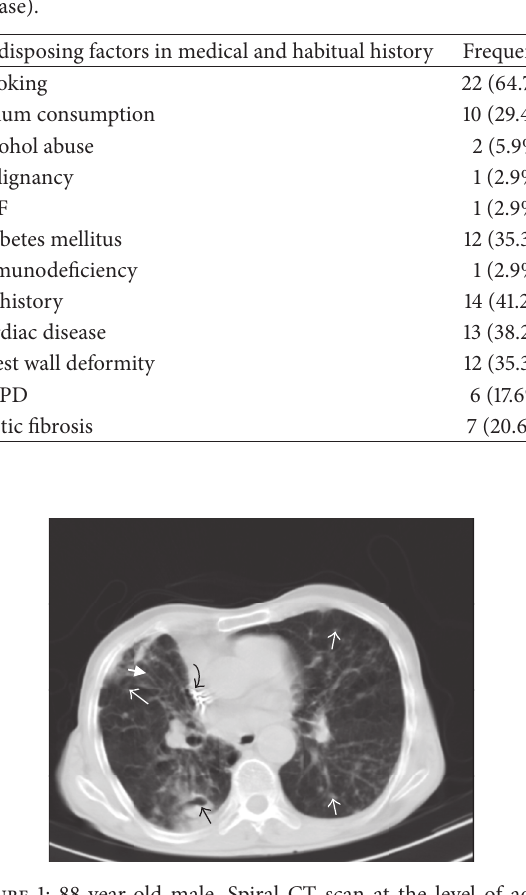
Figure 1: 88-year-old male. Spiral CT scan at the level of aortic root (lung window). Cavitary nodule in right lower lobe (black arrow) along with nodular infiltration in left lower lobe, lingula, right lower lobe, and right middle lobe (white arrows). Note also cylindrical bronchiectasis in right middle lobe (thick white arrow).